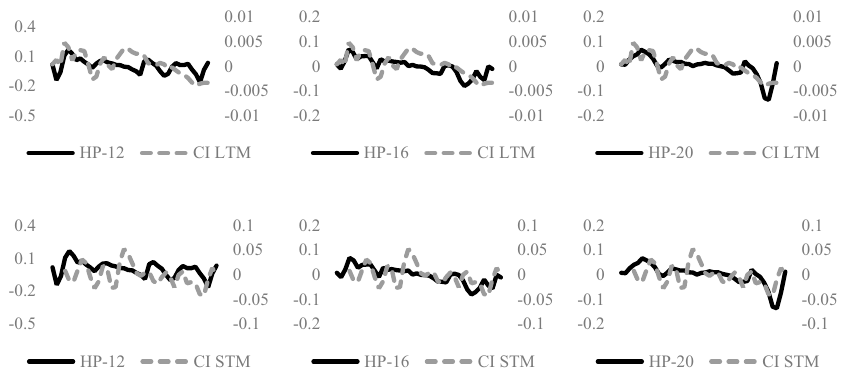
Fig. 2 BCS and IT credibility series in the first logarithmic difference, 2006–2015. Source : Own elabora- tion Table 2 Correlations between credibility and synchronization measures. Source : Own